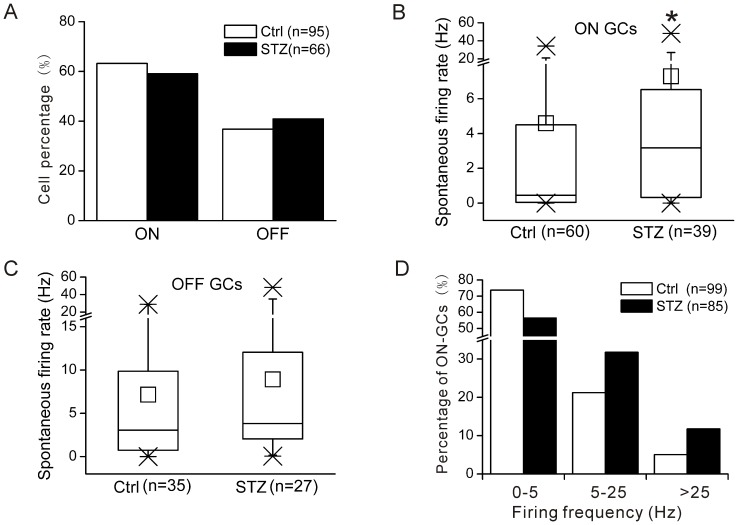
Spontaneous firing rates of ON-type ganglion cells were increased in diabetic mice.A. The percentages of ON- and OFF-type ganglion cells in both control and diabetic mice. B. Box and whisker charts illustrating the distribution of average spontaneous firing rates of ON-type ganglion cells in control and diabetic mice. In the charts, the middle line in the box represents the median, the box ends represent the first and third quartiles, whiskers indicate the 5% and 95% margins, and crosses indicate the data margins. In addition, the mean value is indicated by a small square. The diabetic ON-type ganglion cells showed a significant increase in spontaneous firing rate (*P<0.05, Mann-Whitney U test). C. Box and whisker charts illustrate the distribution of the average spontaneous firing rates of OFF-type ganglion cells in control and diabetic retinas. No difference was detected in spontaneous activity in OFF-type ganglion cells between control and diabetic groups (P>0.05). D. Histograms showing the percentage of all ON-type ganglion cells recorded as a function of firing frequency. The first band includes firing rates from 0–5 Hz, the middle band includes firing rates of 5–25 Hz, and the right band represents the firing rates >25 Hz. In diabetic mice, a considerable decrease was observed in the percentage of cells with an average firing frequency <5 Hz, but in the other two frequency bands (≥5 Hz) the percentage of diabetic cells were larger than the control group.